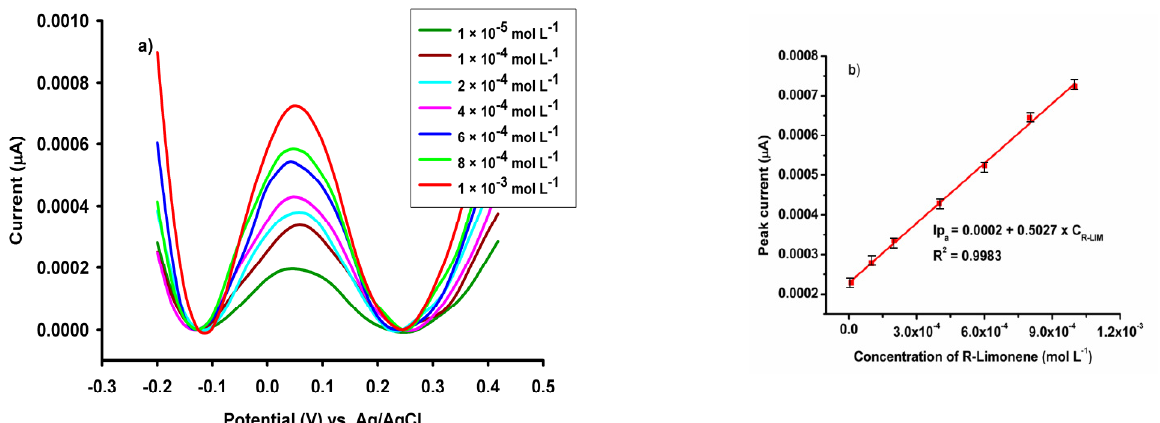
Figure 7. ( a ) Differential pulse voltammograms recorded with the Fe(TPFPP)Cl/AuNPs-S-Gr sensor in PBS pH 3.0 containing different concentrations of R-limonene from 1 × 10 − 5 mol L − 1 to 1 × 10 − 3 mol